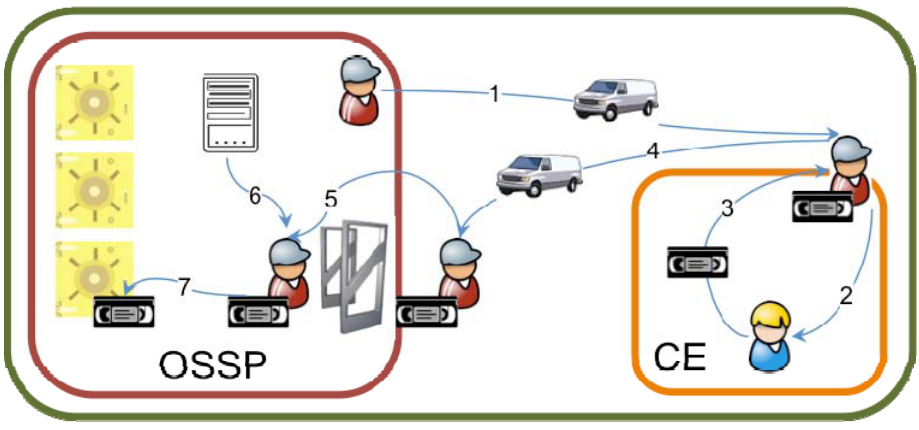
Figure 1. Custody unit retrieval use case.